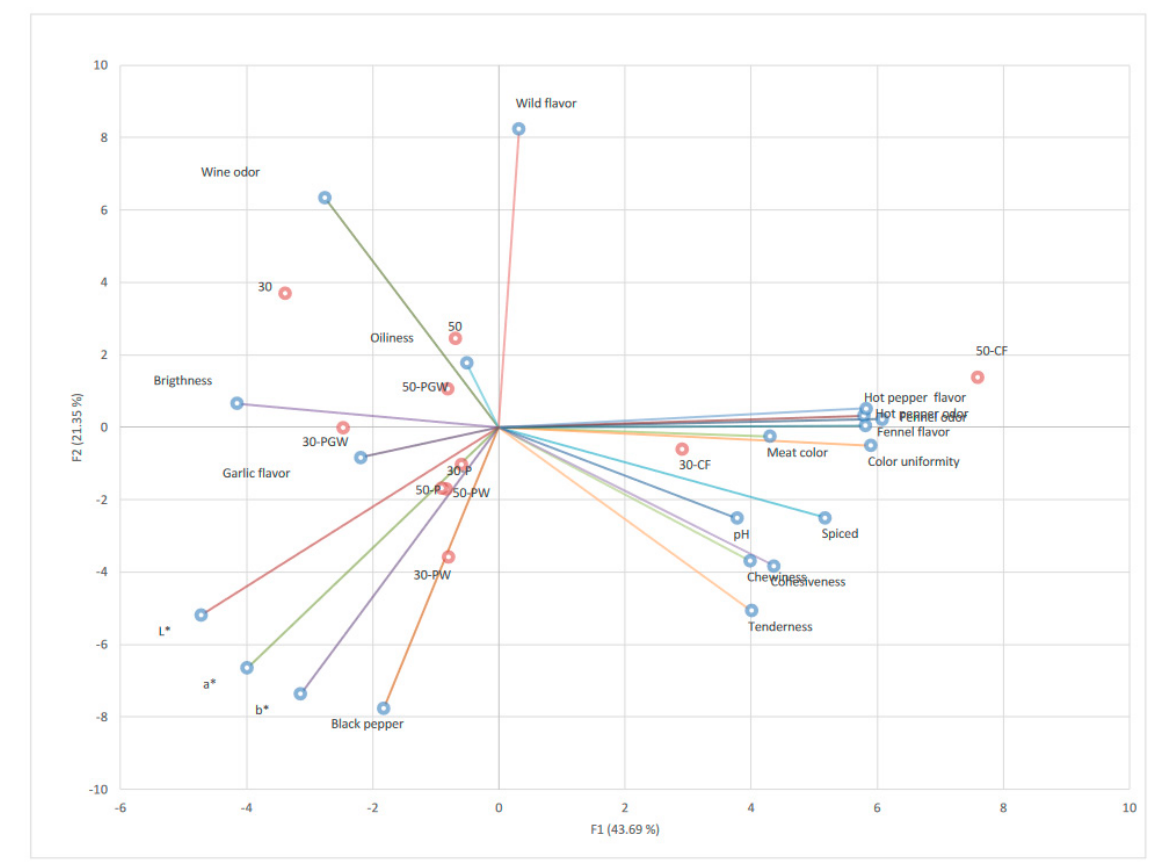
Figure 1. Principal component analysis (PCA).